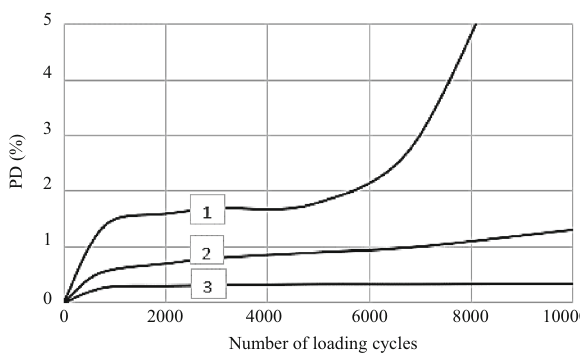
Fig. 10 Typical three different types of PD